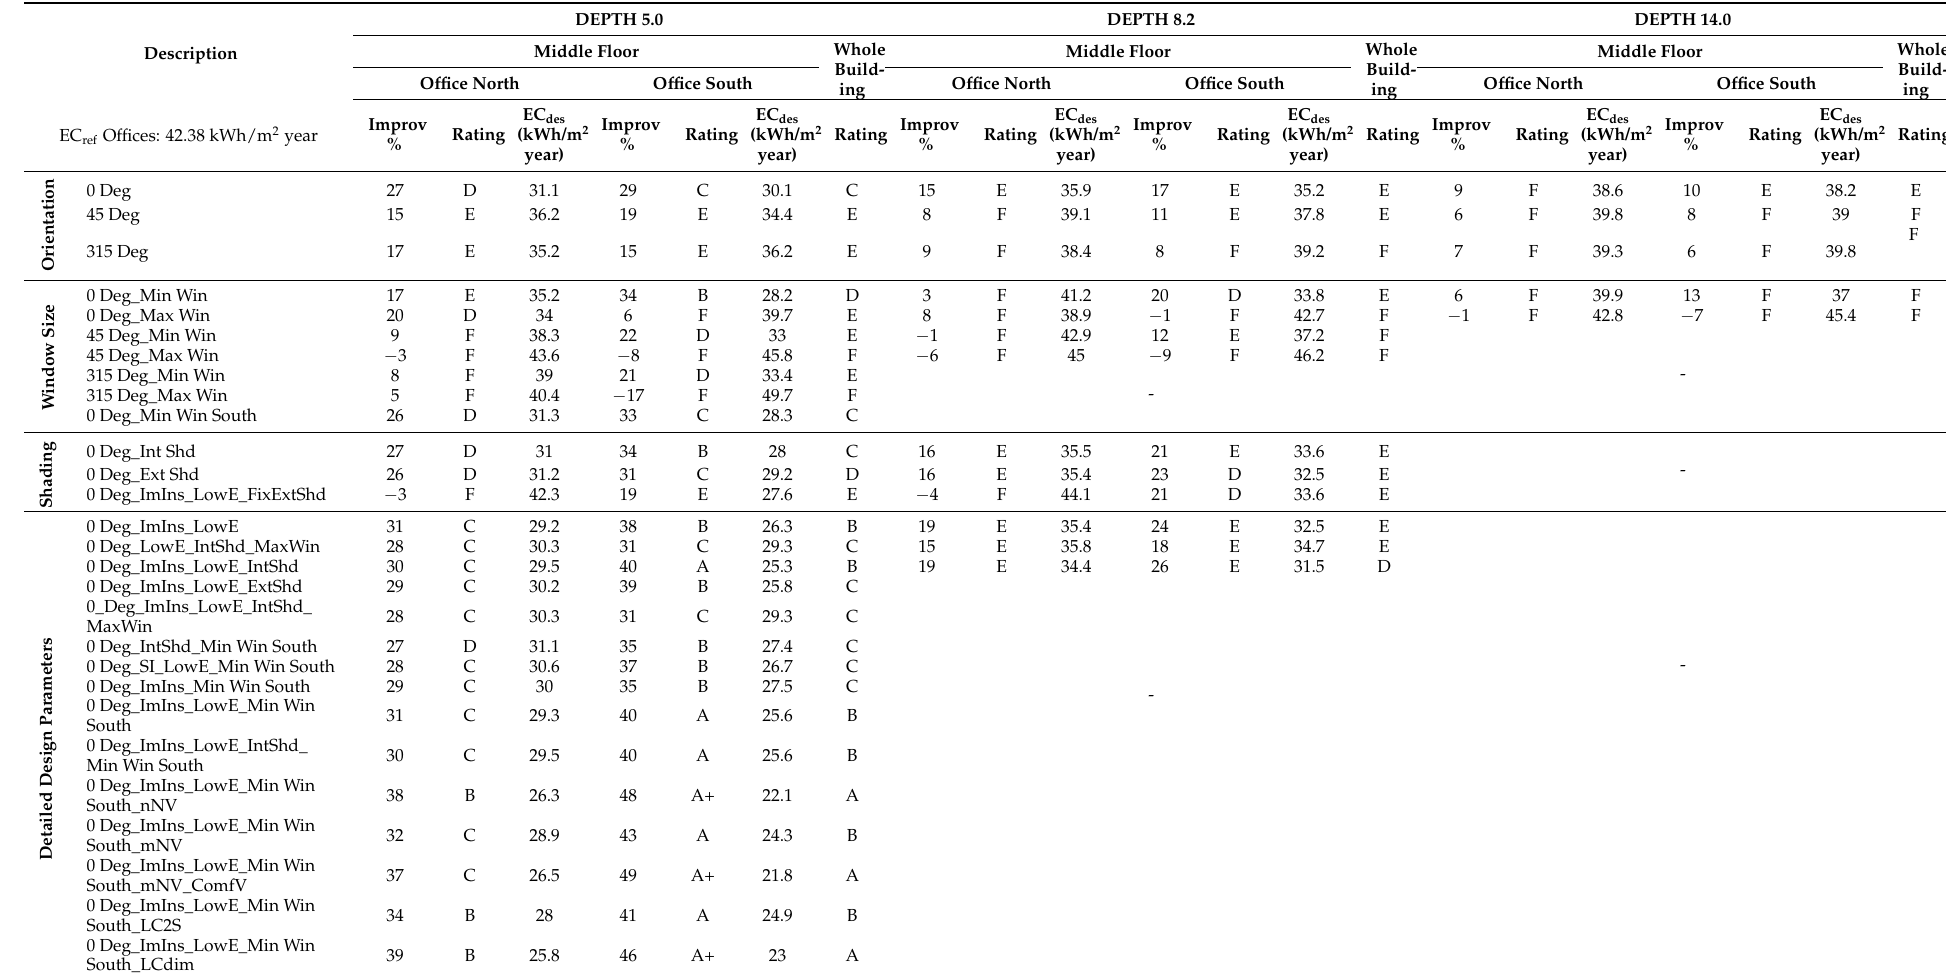
Table 4. Office building case with design path showing improvements of design